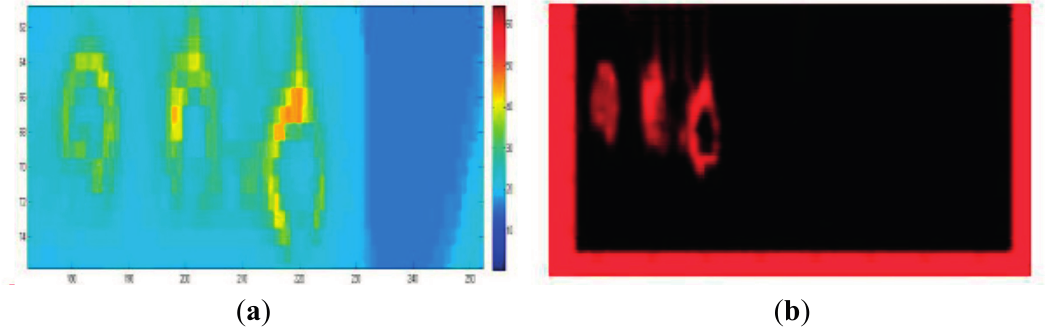
Figure 15. Thermal image on the solder top: ( a ) The original thermal image on the top; ( b ) The thermal image through Gauss